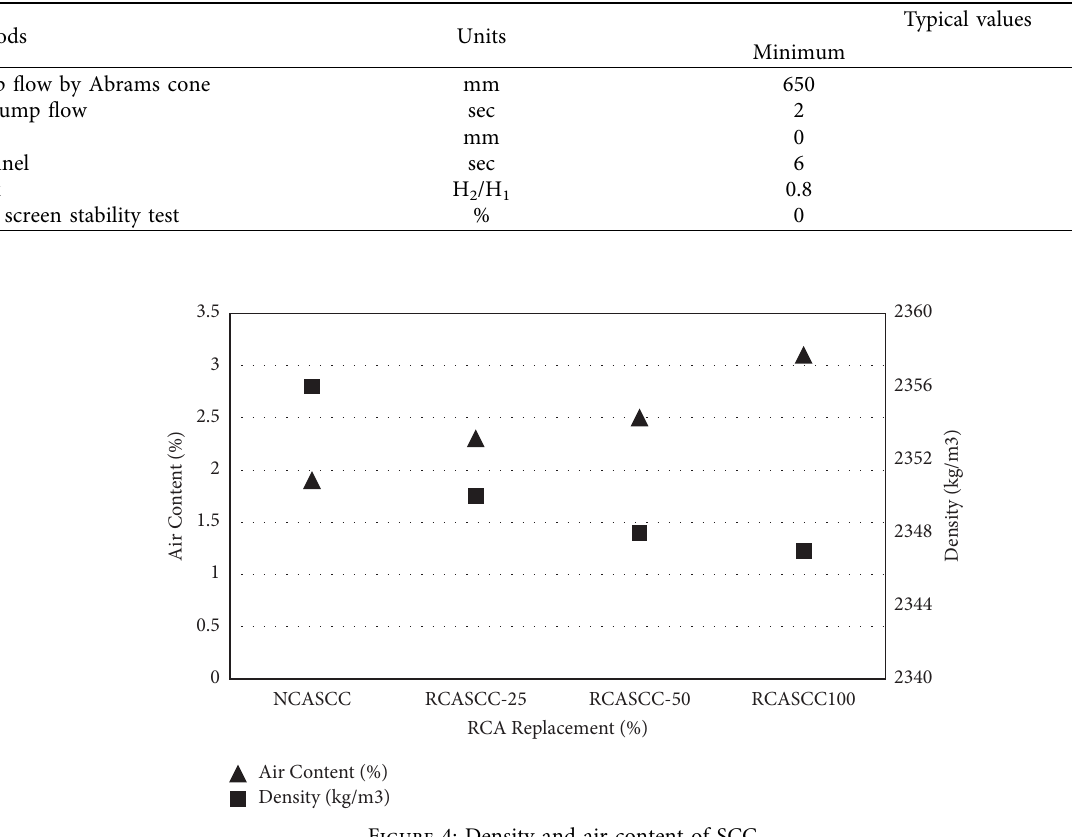
Figure 4: Density and air content of SCC.